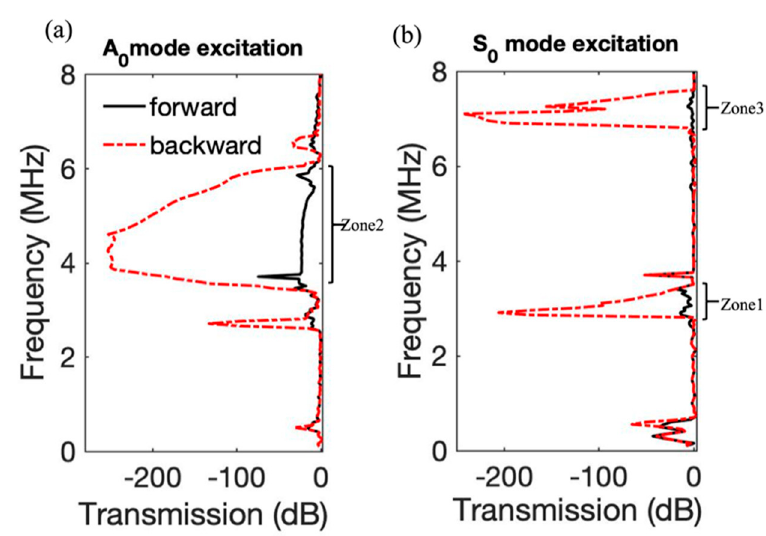
Figure 5. Transmission of the A 0 (a) and S 0 (b) Lamb mode excitations in forward and backward directions. The backward transmission is prohibited in Zone 2 for A 0 excitation and in Zones 1 and 3 for S 0 excitation, while the forward transmission is allowed in these frequency ranges.